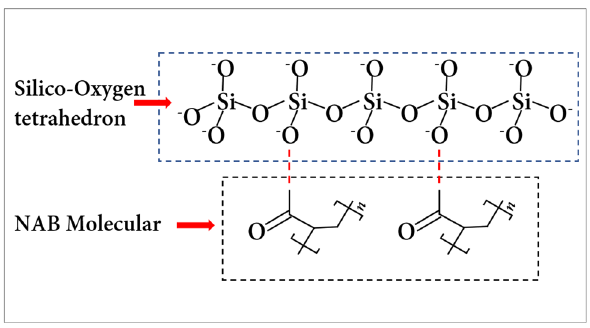
Figure 9. Mechanism diagram of NAA improving clay.